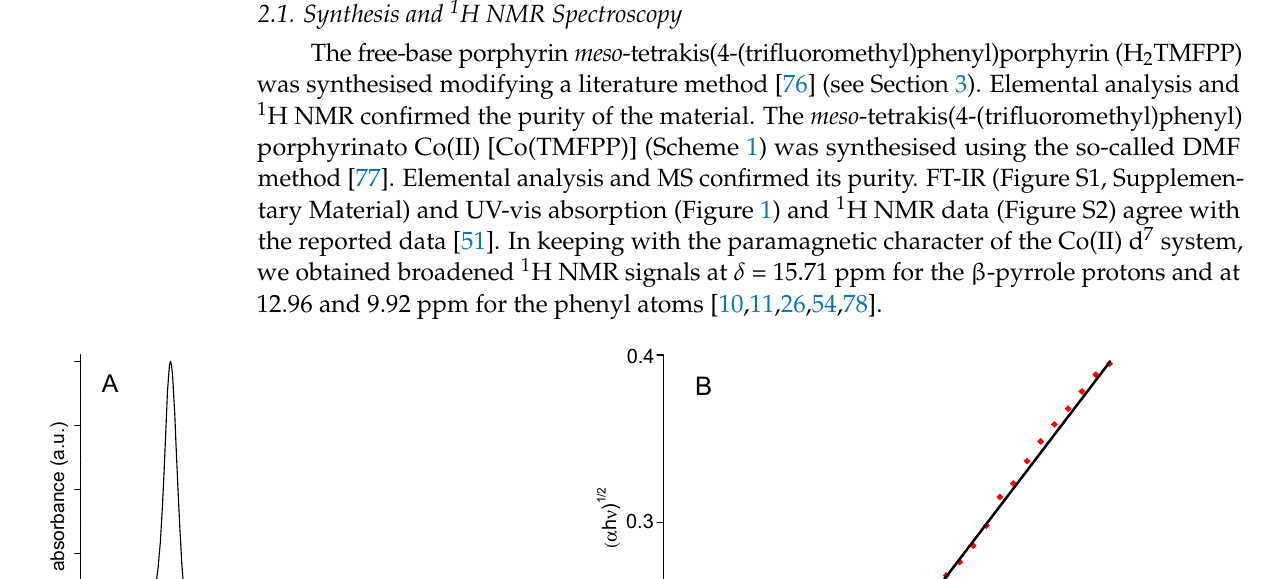
Scheme 1. Structures of [Co(TMFPP)], crystal violet (CV) and malachite green (MG).